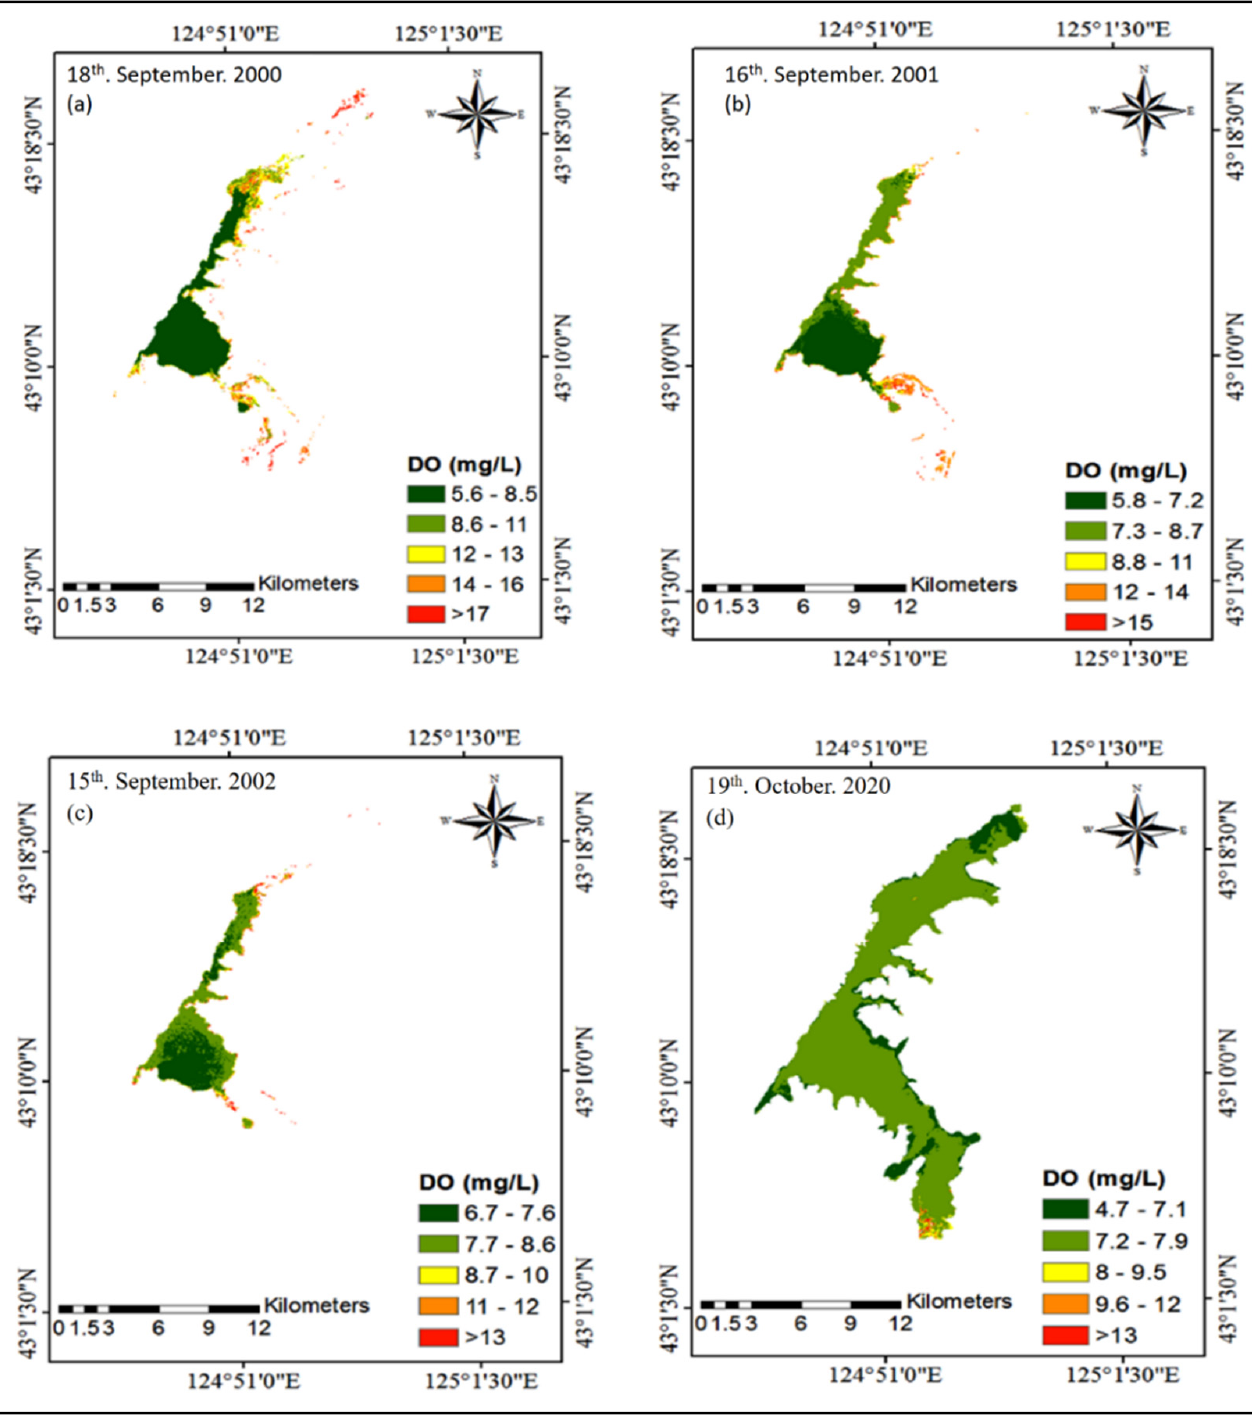
Figure 8. Spatial distributions of dissolved oxygen (( a ) spatial distributions of DO on 18 September 2000, ( b ) spatial distributions of DO on 16 September 2001, ( c ) spatial distributions of DO on 15 September 2002, ( d ) spatial distributions of DO on 19 October 2020), estimated via models gener- ated from Landsat (TM, ETM, and OLI8) in Erlong Lake.